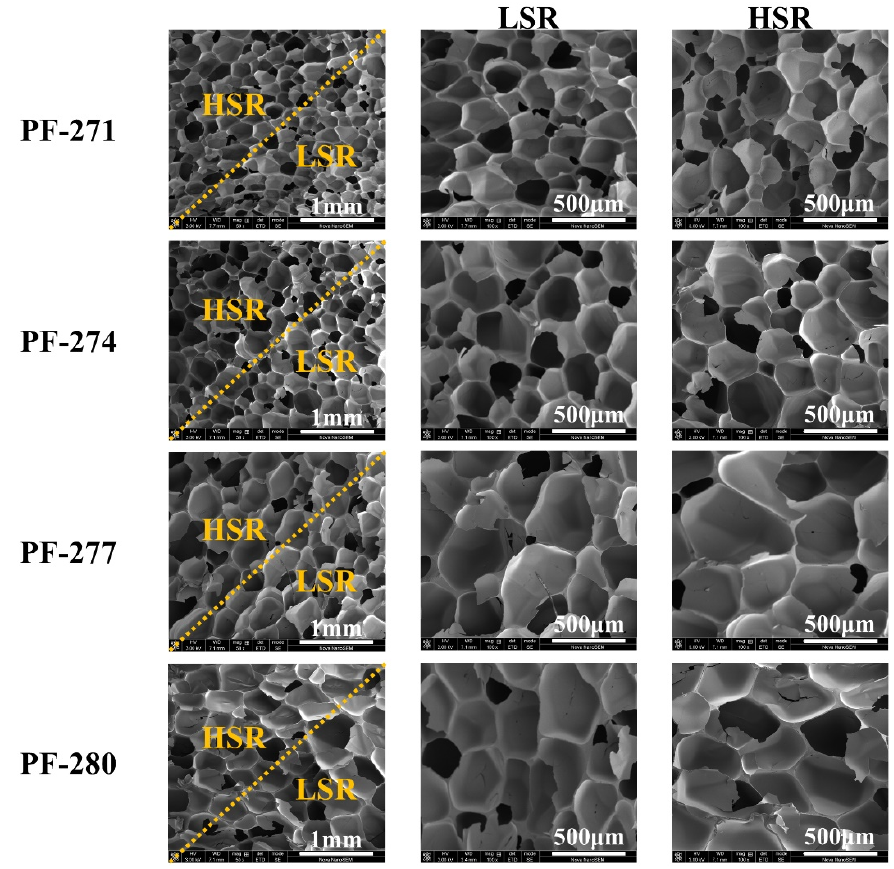
Figure 12. SEM graphs of PET foam morphology.